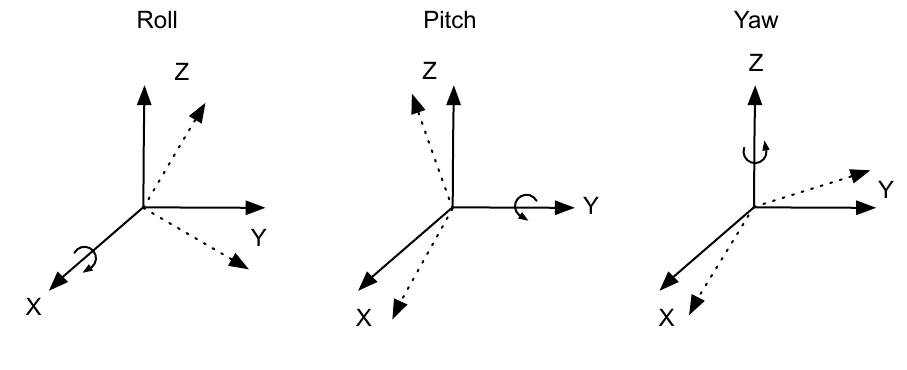
Figure 7. Roll, pitch and yaw